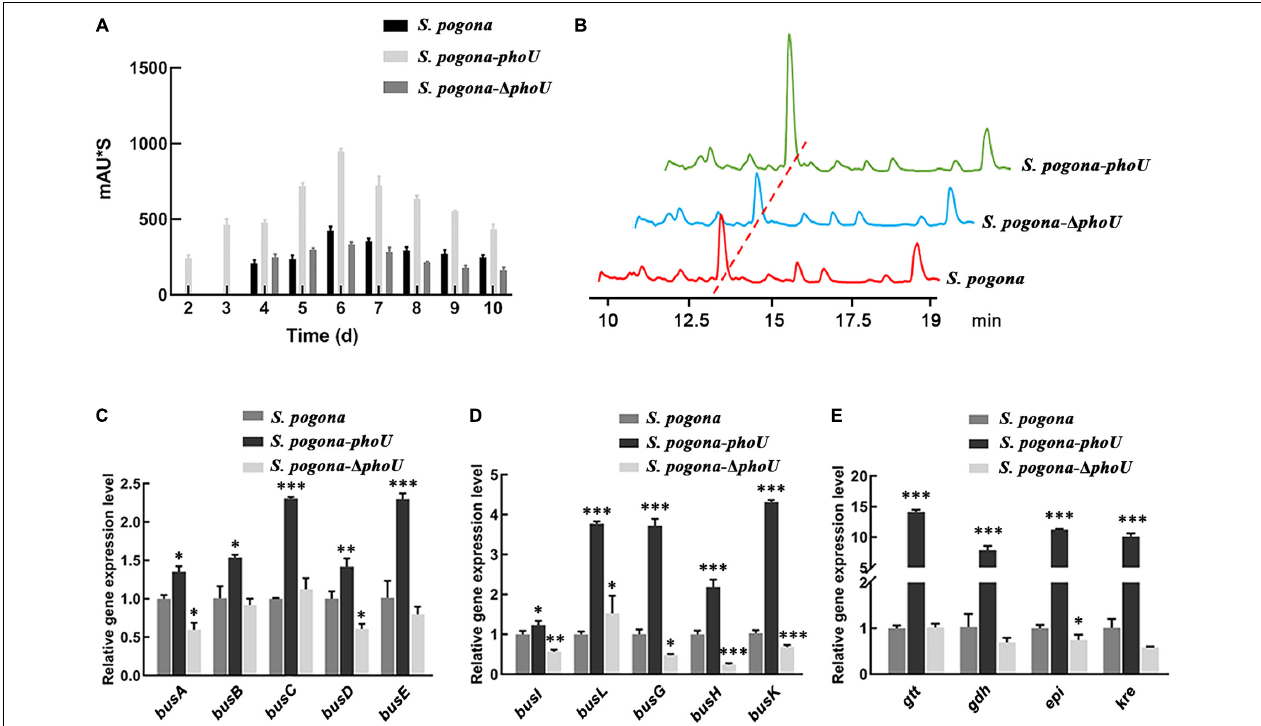
FIGURE 2 | Analysis of butenyl-spinosyn yield and bus genes transcriptional levels. (A) Accumulation of butenyl-spinosyn at different time points. (B) Comparative analysis of butenyl-spinosyn production. The detection wavelength was set at 250 nm during analysis, and the chromatographic peak of butenyl-spinosyn appeared at 13.1 min. (C–E) Comparison of the transcriptional levels of bus genes and rhamnose biosynthesis genes ( gtt , gdh , epi , and kre ) between the wild-type and mutant strains. The transcription levels of the above genes were significantly increased in Saccharopolyspora pogona - phoU . In contrast, most of the genes were downregulated in S. pogona - (cid:49) phoU . mRNA samples were isolated from the wild-type and engineered strain cells cultured for 144 h. The 16S rRNA gene was used as an internal control to quantify the relative expression of the target genes. The error bars indicate the standard deviations of three biological replicates. *, **, and *** indicate P < 0.05, P < 0.01, and P < 0.005, respectively, compared to S. pogona under the same conditions.